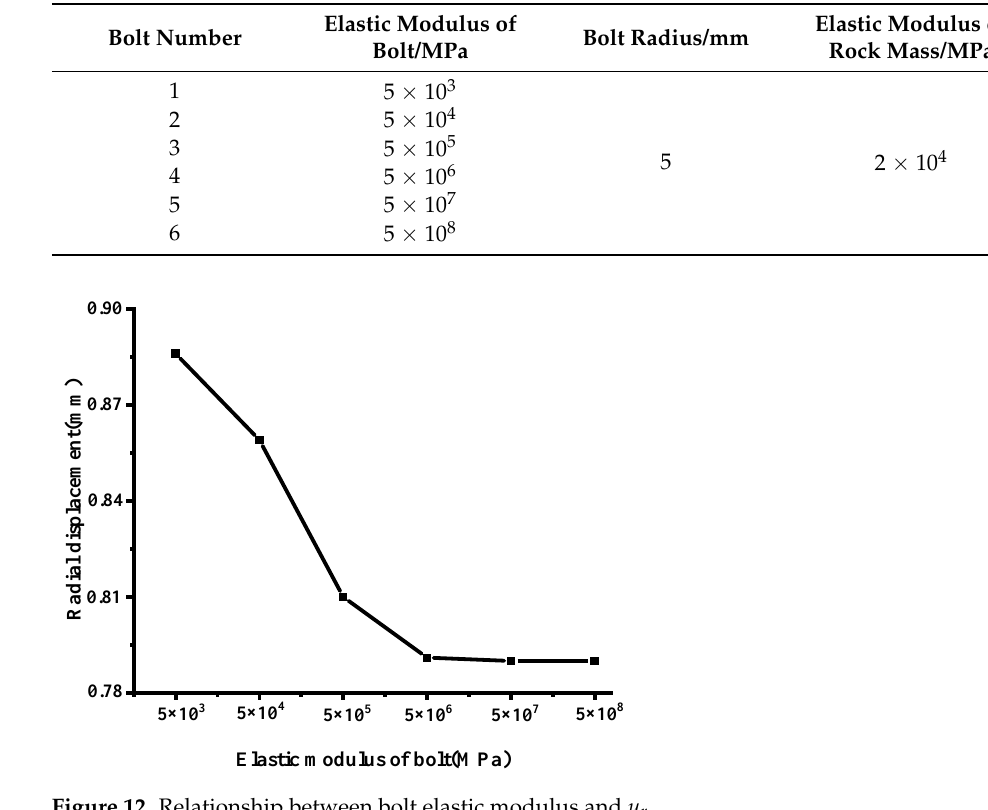
Table 2. Bolt number and elastic model parameters.